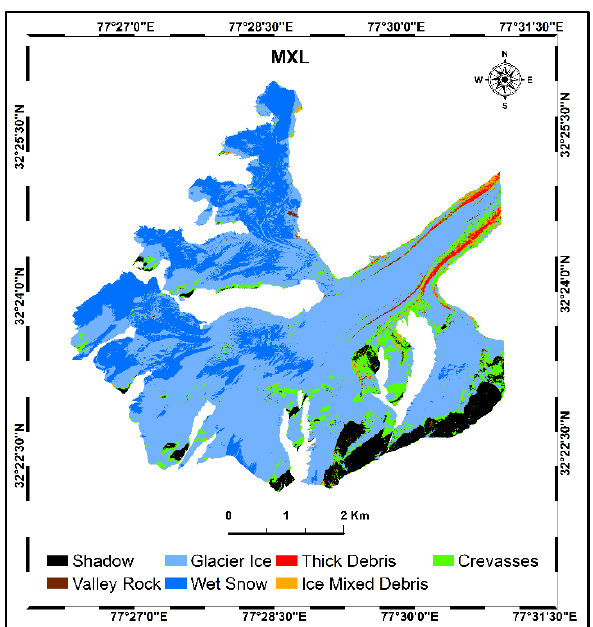
Figure 5. Maximum likelihood classification map